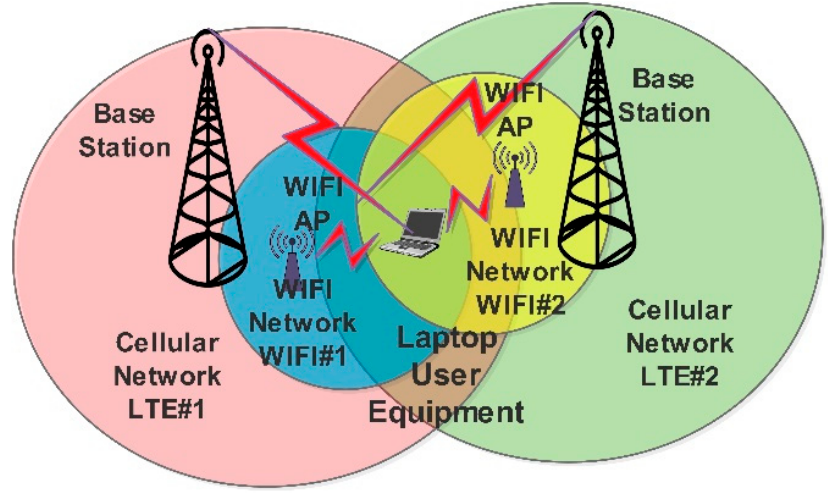
Figure 6. MH in a HetNet scenario. Figure 6 . MH in a HetNet scenario .